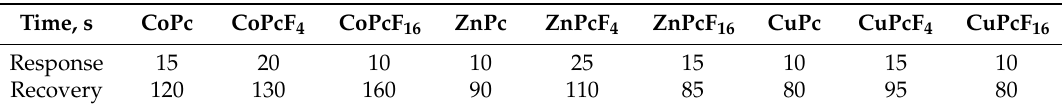
Table 1. Average values of response and recovery times of MPc, MPcF 4 , and MPcF 16 films at the concentration of ammonia 10 ppm.